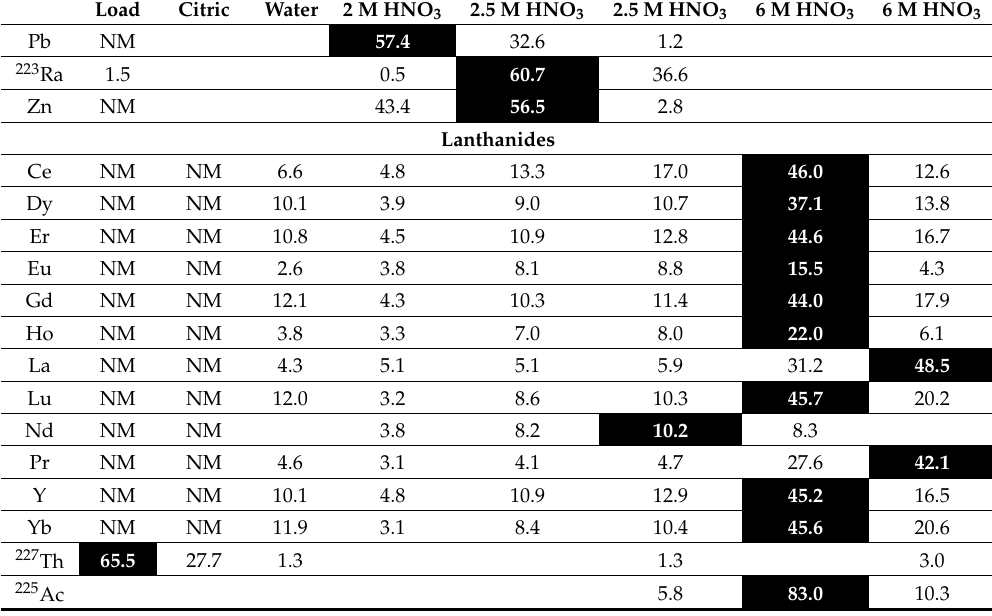
Table 2. Percentage of eluted elements in the various steps of the separation using the following rinse sequence: 3 mL of 1 M citric acid pH 2, 3 mL of water, 3 mL of 2 M HCl, 3 mL of 3 M HCl, 3 mL